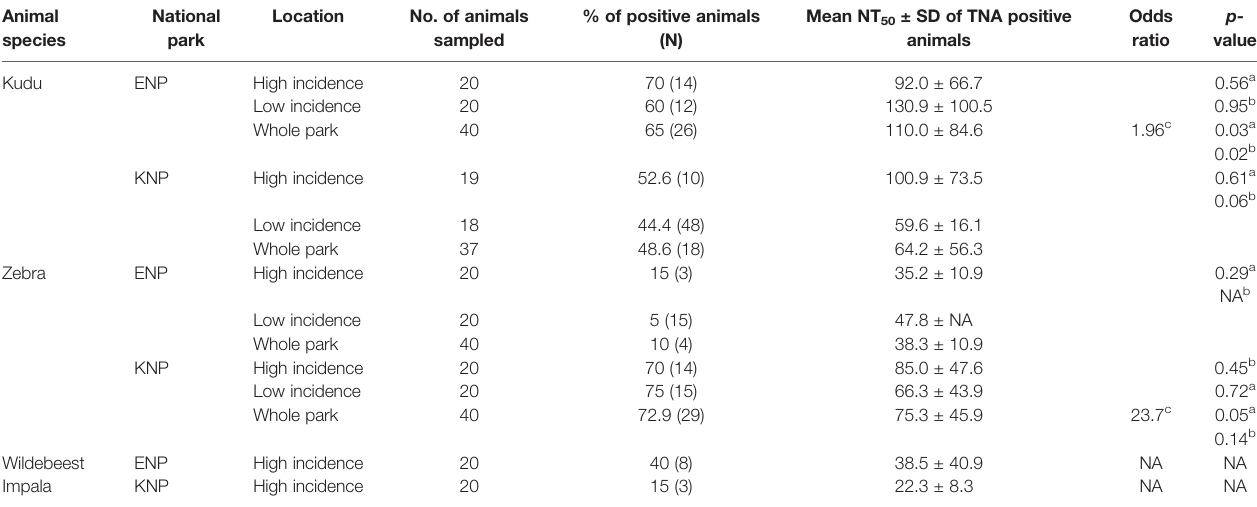
TABLE 2 | Lethal toxin (LT) neutralization titres and proportion of herbivores that neutralized anthrax LT in Kruger National Park (KNP), South Africa, and Etosha National Park (ENP), Namibia. Animal species